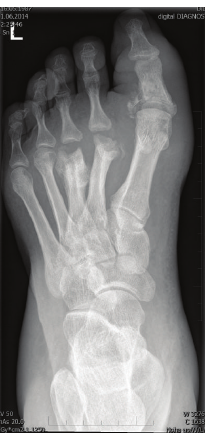
Figure 3: Dorsoplantar X-ray image of the left foot. Resorptive changes I–III MTP of the joints.